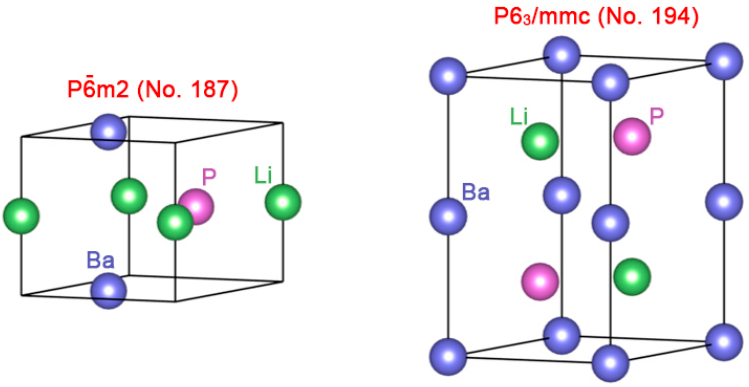
Figure A1. The different crystal structures for BaLiP under the two space groups. Spheres of different colors represent different atoms, as also labeled by the color text. Note the two structures contain different total number of atoms.